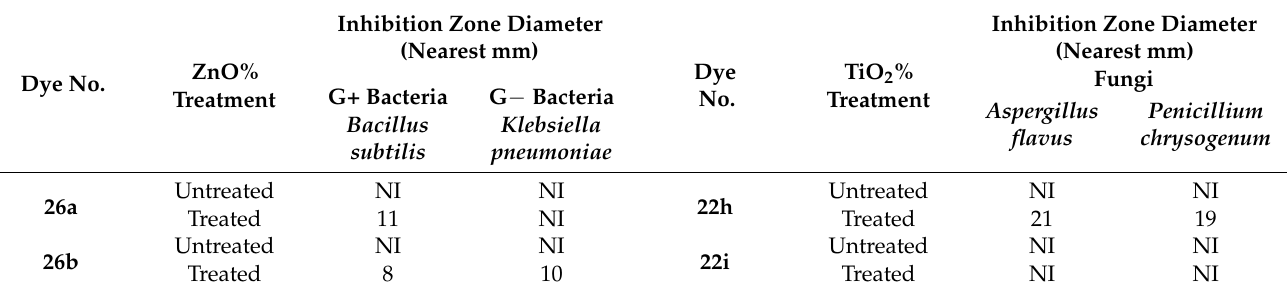
Table 8. Inhibition zone diameters of the dyed polyester fabrics of disperse dyes 26a and 26b against Gram-positive, Gram-negative bacteria and